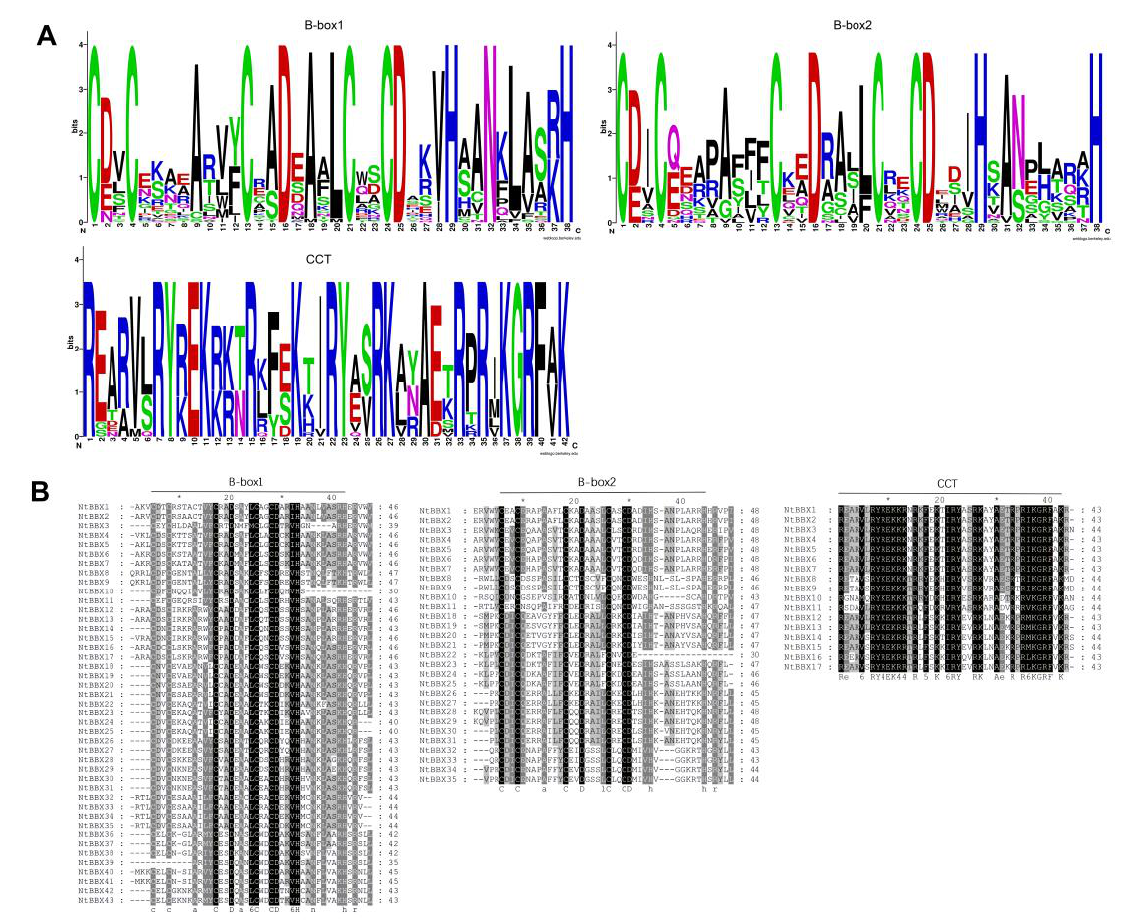
Figure 3. Sequence characteristics of domains of NtBBX proteins. ( A ) Sequence logos alignment of the B-box1, B-box2, and CCT domains. Each colored letter represents an amino acid residue. The height of amino acids is directly proportional to the conservation of amino acids in this position; ( B ) Multi-sequence alignment of the B-box1, B-box2 and CCT domains of the NtBBX proteins. The black background means that the amino acids here are absolutely conservative.